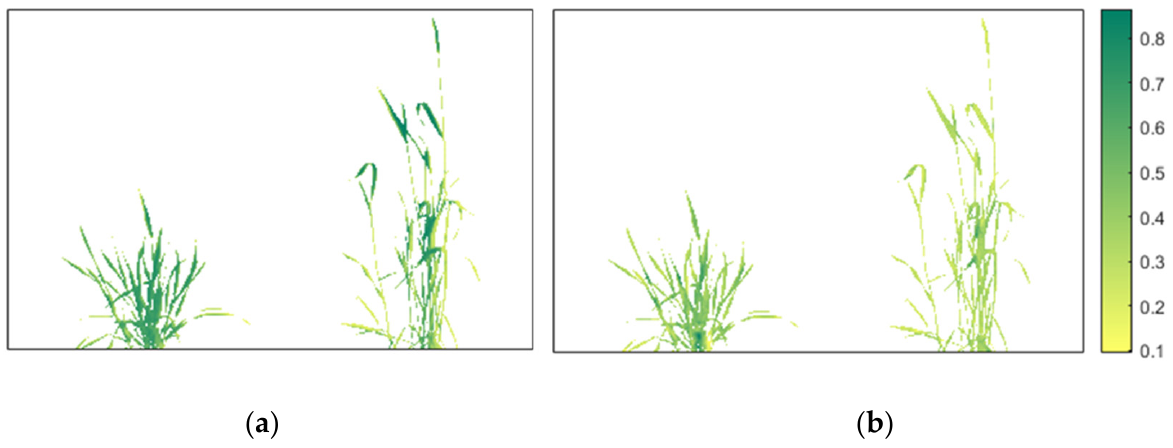
Table 2. Vegetation indices generated from the image processing pipelines.